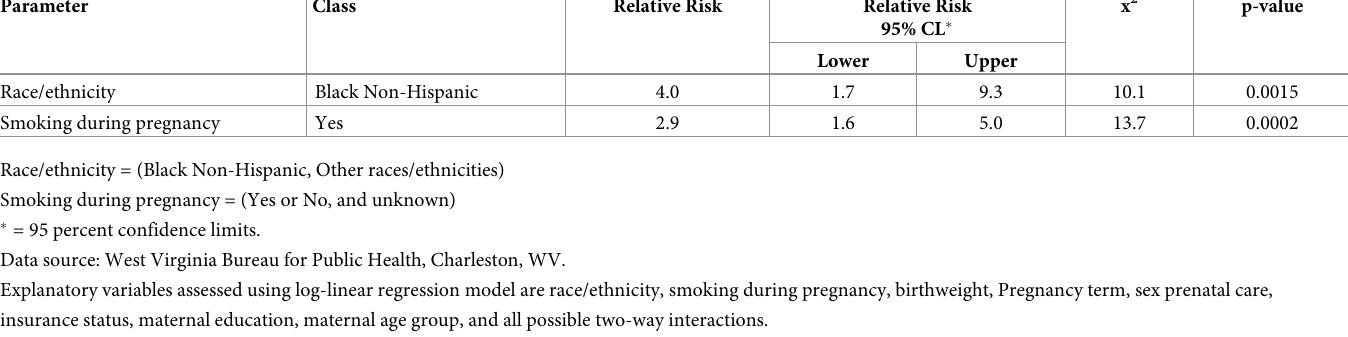
Table 2. Relative risk for maternal characteristics associated with injury-related infant deaths, WV 2010–2014.